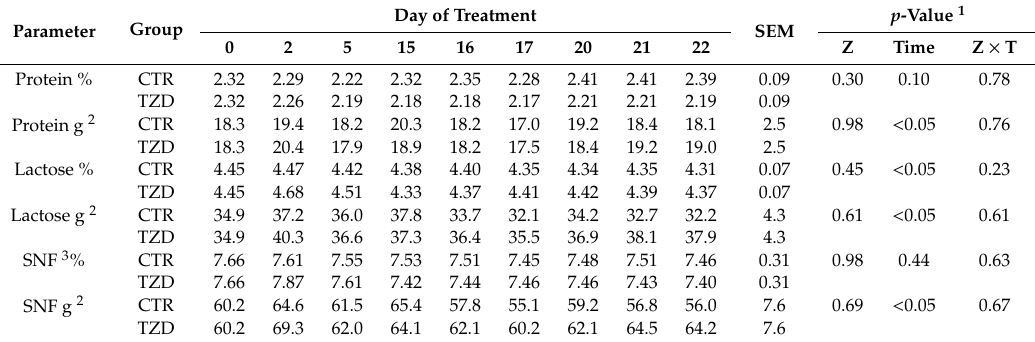
Table 1. Milk components in lactating goats injected daily with 2,4-thiazolidinedione (TZD) or saline